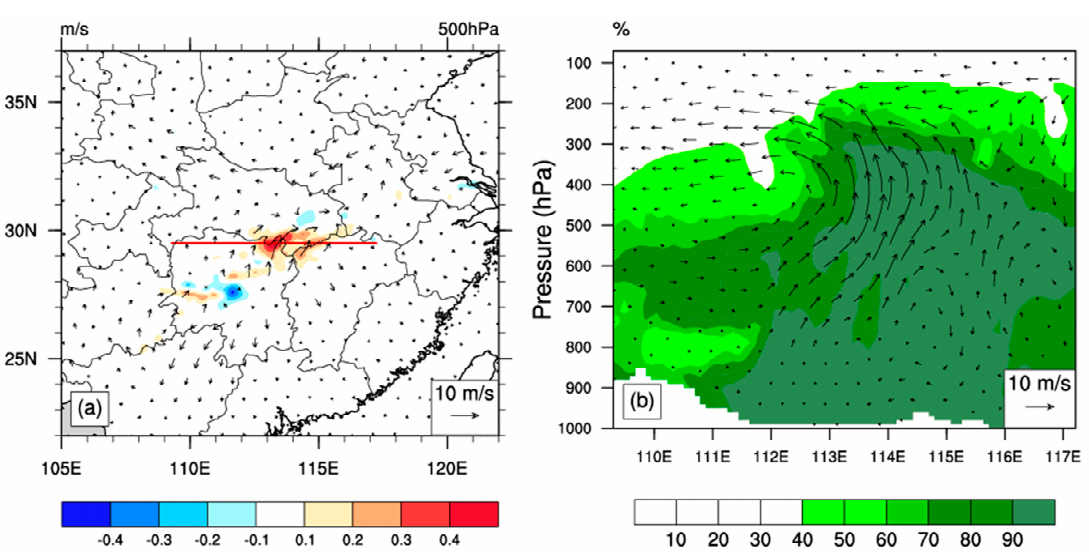
Figure 13. ( a ) The increment of vertical velocity (shaded, m/s) and horizontal wind field (vector) at 500 hPa. ( b ) The east-west cross-section of analysis relative humidity (shaded, %) and wind field increments along the red line in ( a ).